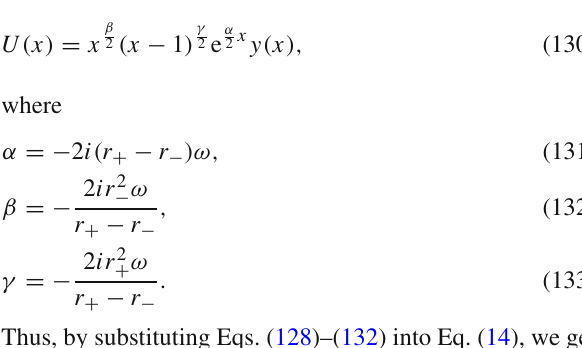
Fig. 11 (AdS) Case 1: a < 0. The first three squared QBS angular wave eigenfunctions as a function of the new polar coordinate z ; a = − 0 . 20, R = 1, N = 0, M = 0 .